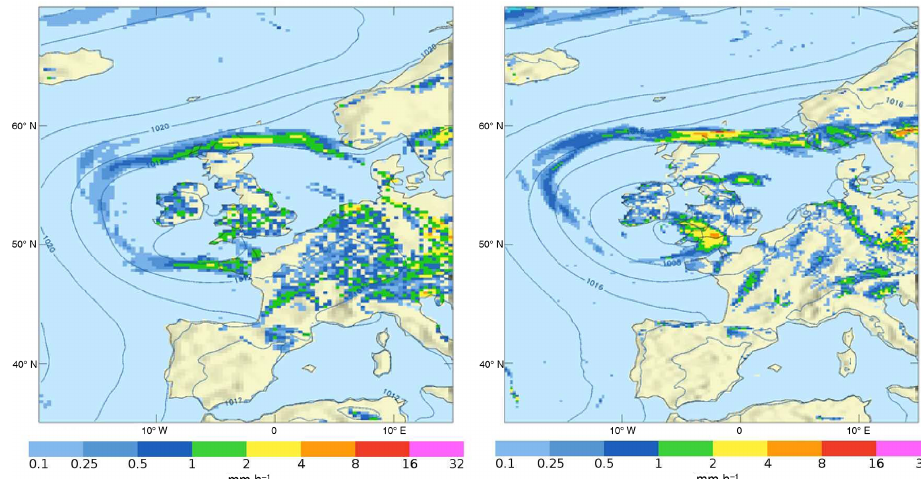
Figure 16. 108h forecast rainfall rates from the N512 GA3.1 (left) and N768 GA6.1 trial (right), valid from 12:00UTC 7 July 2012.